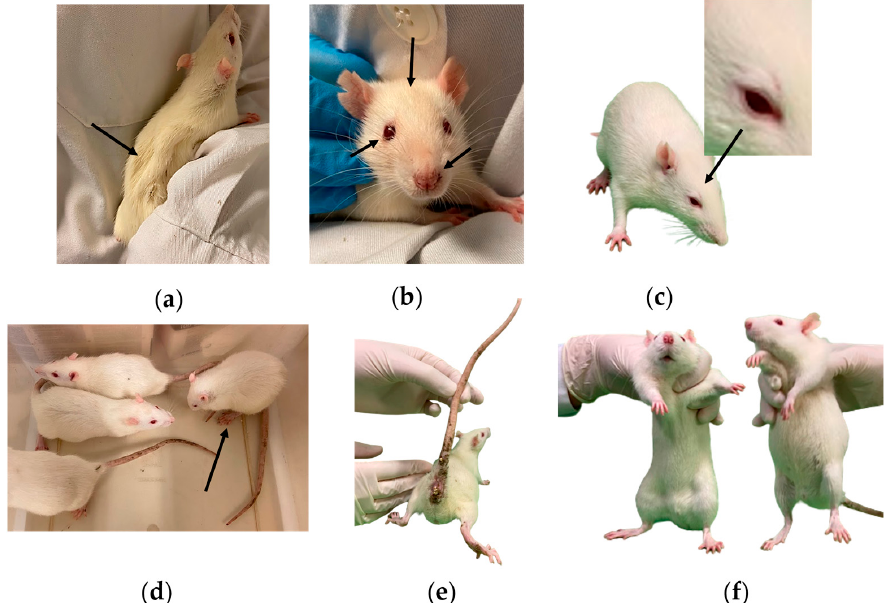
Figure 4. Welfare parameters changed in the induced animals throughout the experimental protocol. ( a ) Dehydration detected by the skin pinch test (black arrow); ( b ) lack of grooming (black arrow); ( c ) narrowing of the orbital area (evaluation of animal expression using the Grimace scale) (black arrow); ( d ) curved posture and isolation from the other animals in the cage (black arrow); ( e ) presence of pasty diarrhea; ( f ) difference between distended abdomen (on the right) and normal abdomen (on the left).